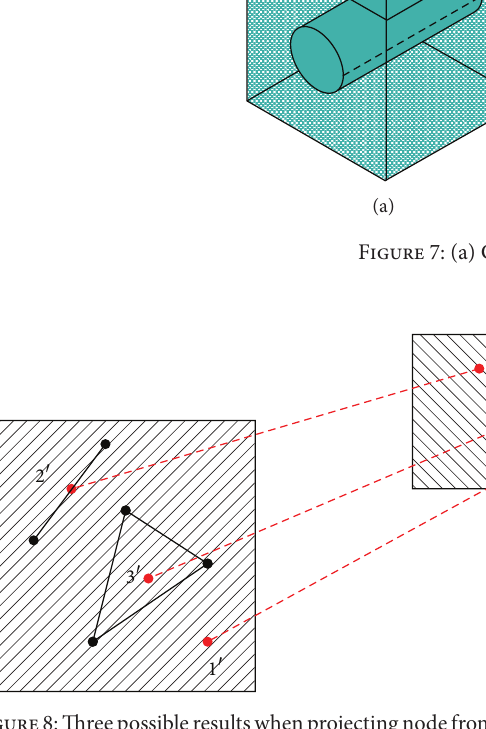
Figure8:Threepossibleresultswhenprojectingnodefromonearea to the